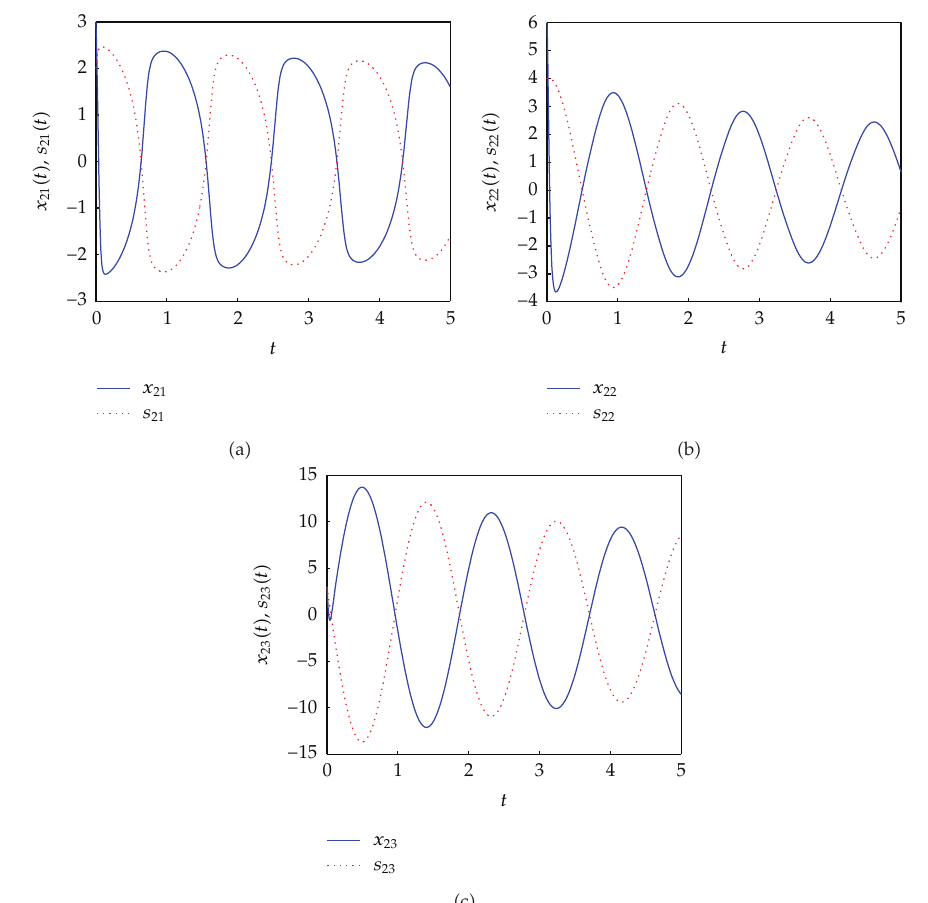
Figure 2: The trajectories of nodes in the second